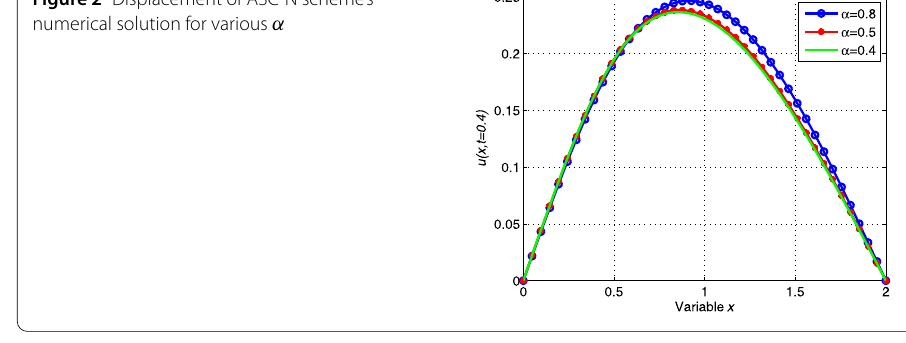
Figure 2 Displacement of ASC-N scheme’s numerical solution for various